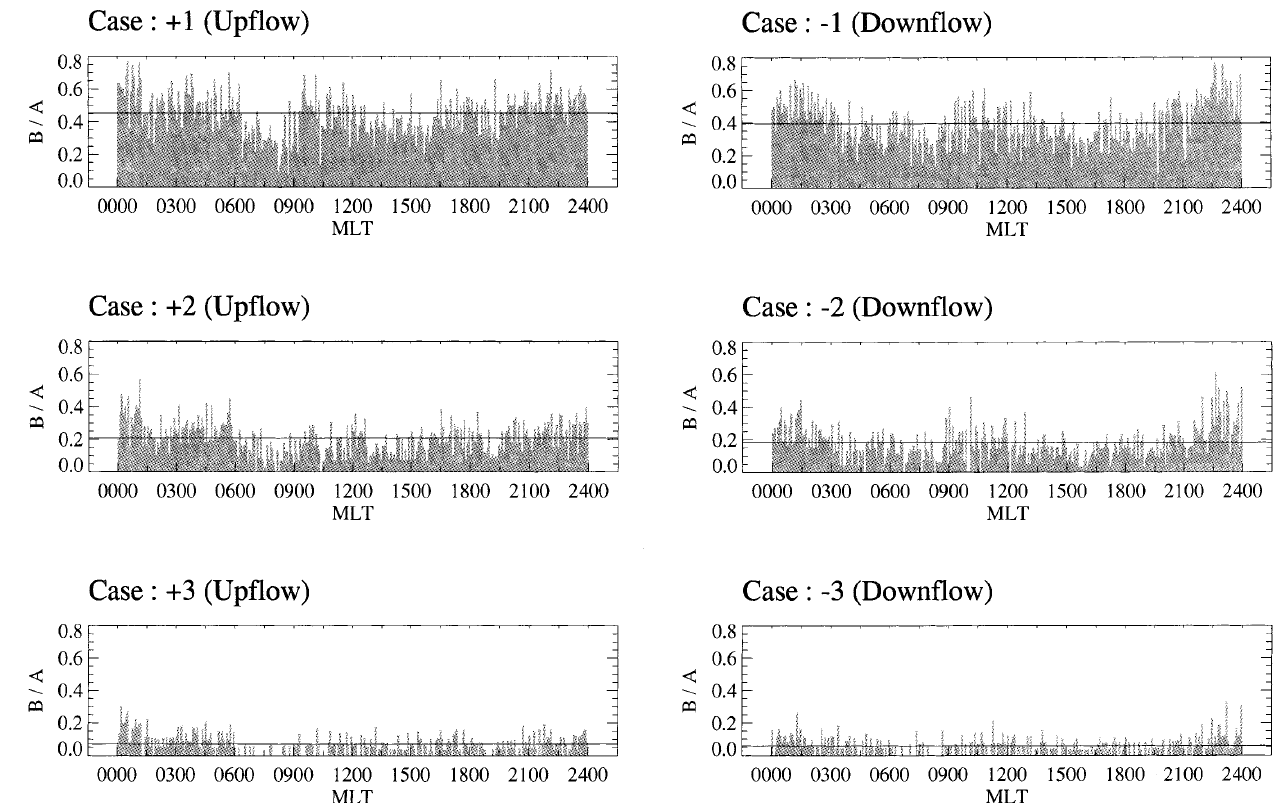
Fig. 4. The magnetic local time (MLT) distribution of the occurrence frequency of the ion upflow ( left ) and the downflow ( right ) for the threshold criterion 1 ( case 1 ) through the threshold criterion 3 ( case 3 ). For both ion upflow and downflow, data only under K